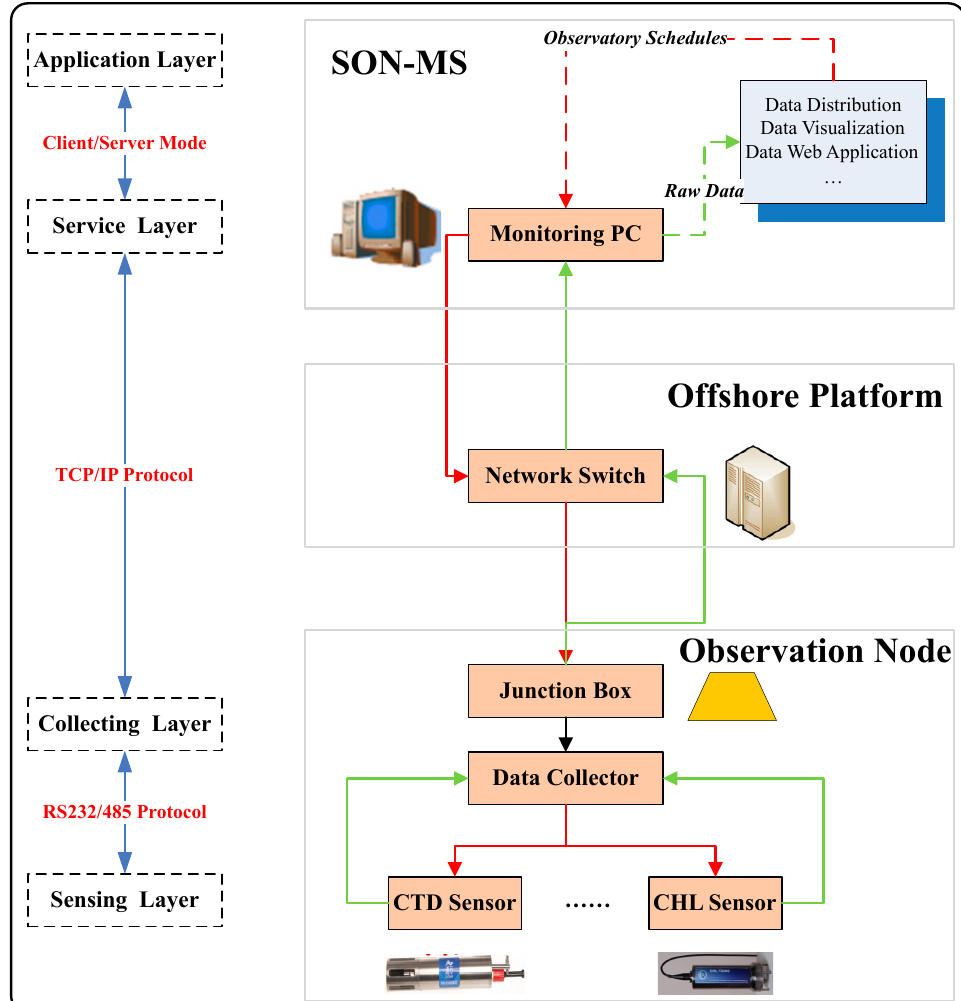
Figure 1. The information oriented architecture of